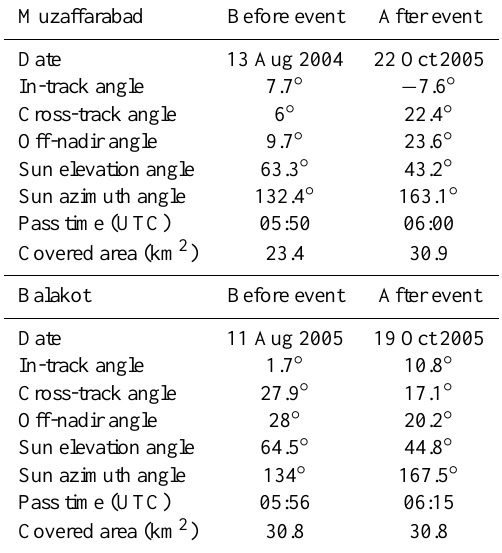
Table 1. Pancromatic quickbird image (0.6m spatial